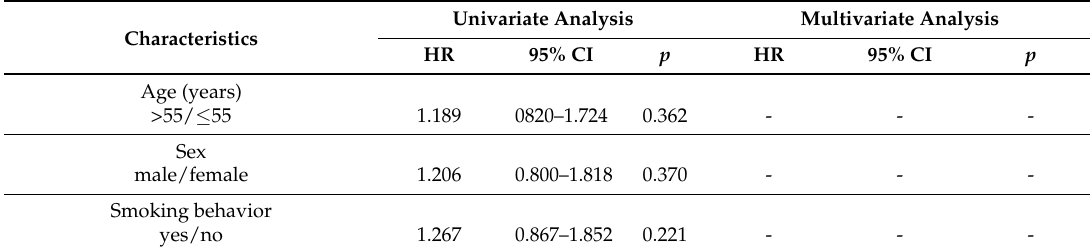
Table 4. Univariate and multivariate analyses of